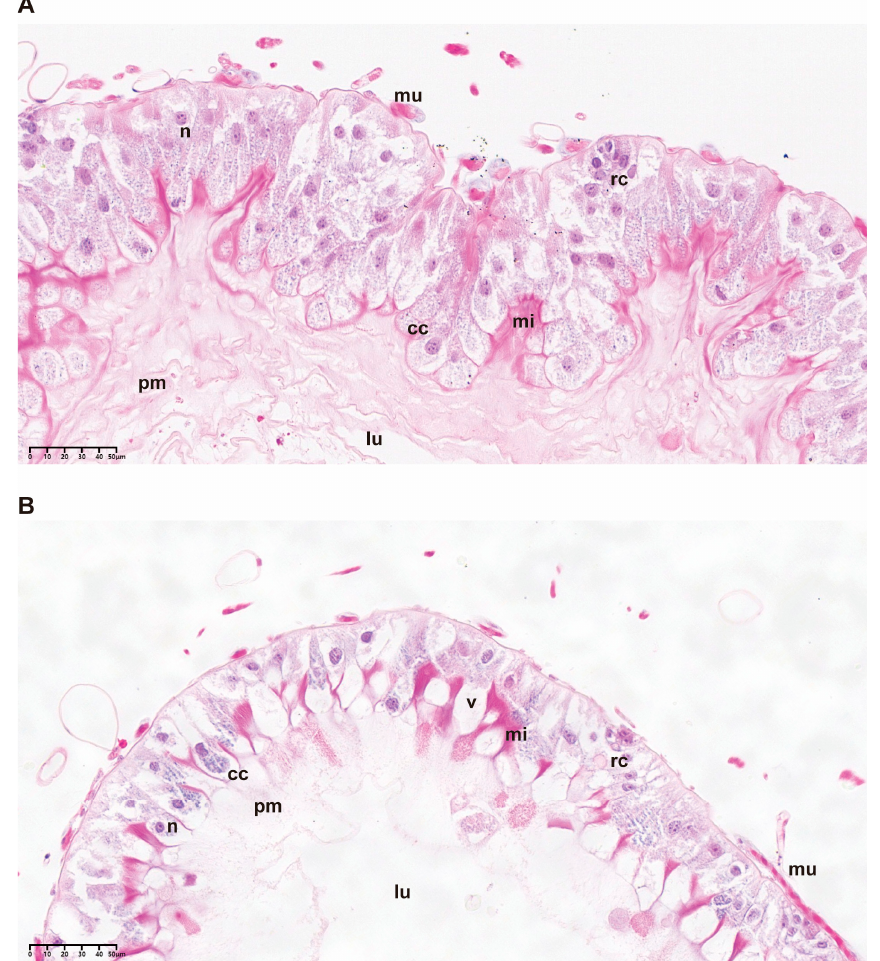
Figure 2. Light micrographs of the midgut of honeybees after 10 d of oral continuous exposure to ABP. ( A ) CTL—acetone syrup control; ( B ) ABP—0.063 mg/mL of fungicide mixture (azoxystrobin: pyraclostrobin: boscalid = 1:1:1, m/m/m). Legend: mu = muscle, n = nucleus, v = vacuole, cc = columnar cells, lu = lumen, mi = microvilli, pm = peritrophic membrane, rc = regenerative cells.